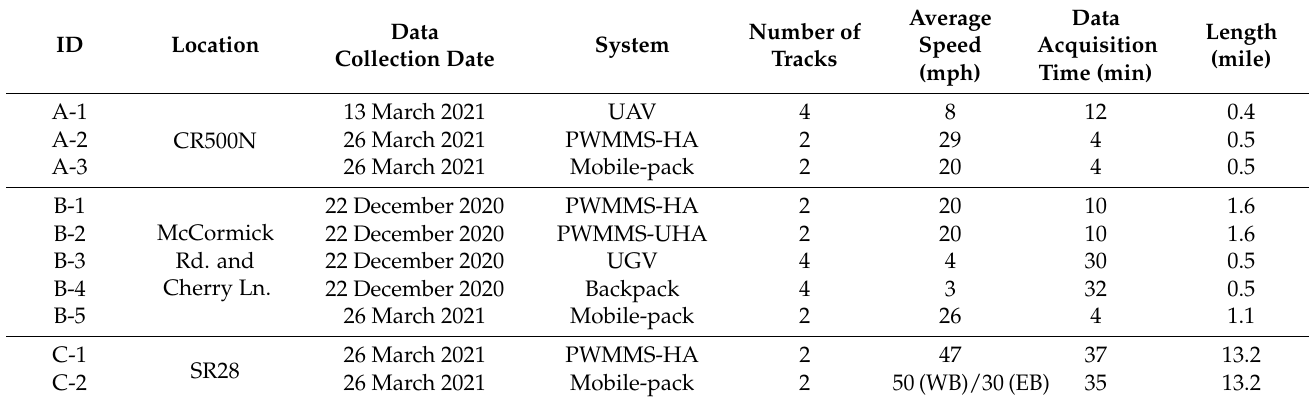
Table 4. Specifications of acquired datasets by the different MLMS units for this study. WB: westbound; EB: